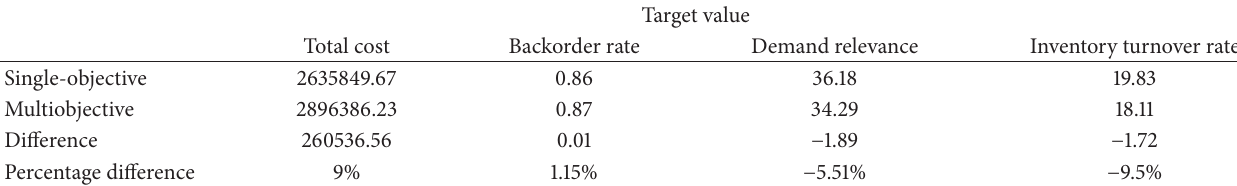
Table 3: Difference analysis of the multiobjective target value and single-objective target value.